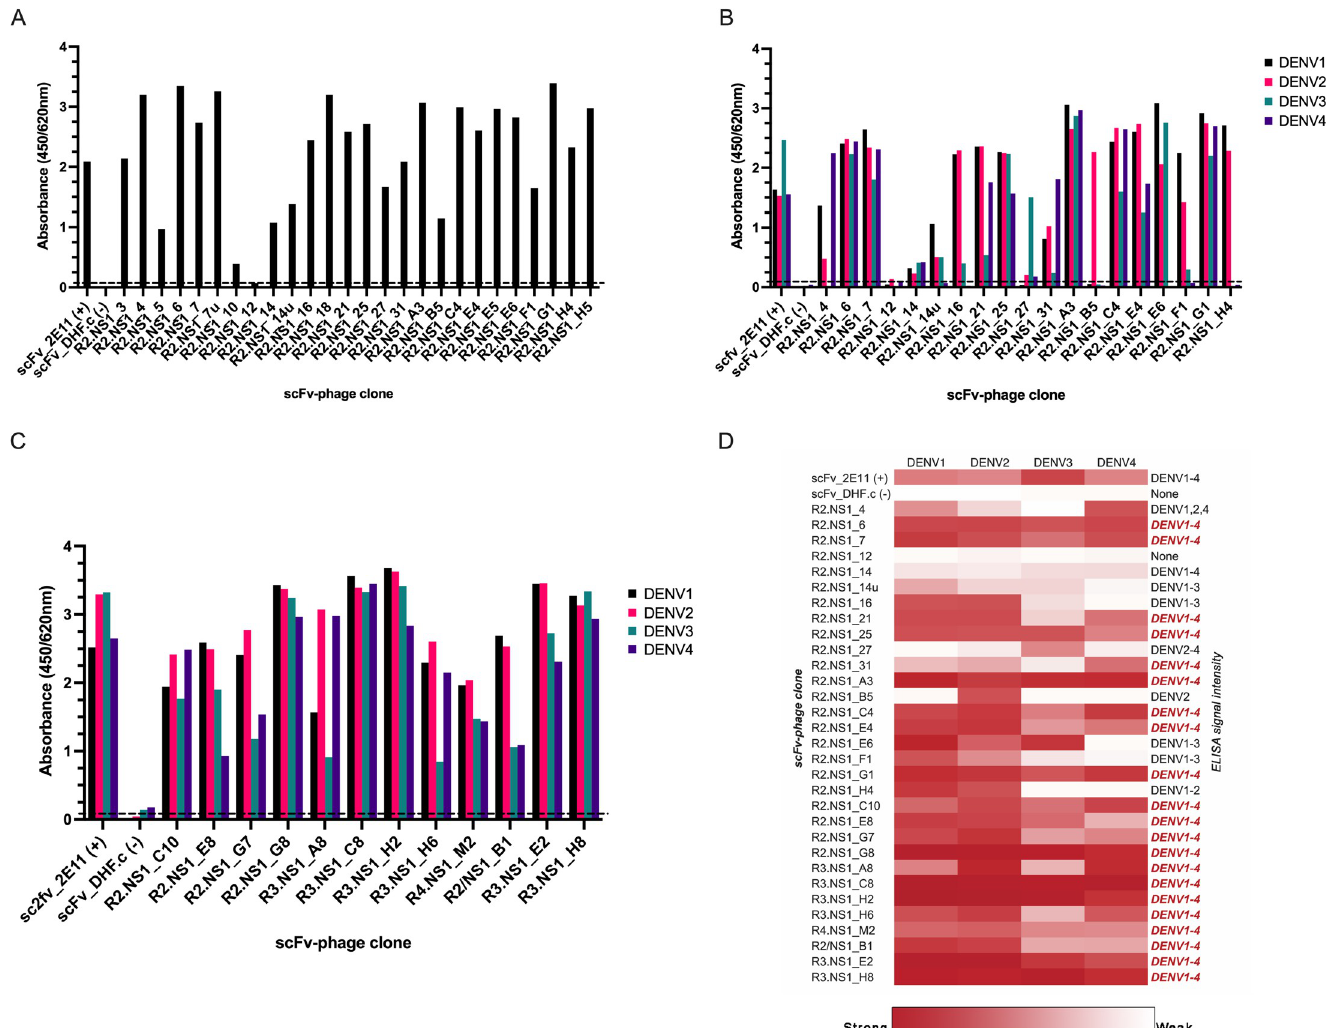
Fig 2. NS1-specific phage clones. (A) The reactivity of the scFv phages biopanned with pooled DENV NS1 was measured by monoclonal phage ELISA using pooled DENV1-4 NS1. (B) & (C) Selected scFv phage clones from the first (pooled DENV1-4 NS1) and second biopanning (separated NS1 from each serotype) experiments were tested with each DENV1-4 NS1 by phage ELISA. The cut-off value shown in (A-C) is OD 450/620 nm. = 0.1. The values are from a single experiment. (D) ELISA signal intensity of the scFv phage’s binding to DENV NS1 obtained from two experiments is shown in a heat map. The spectrum of red to white indicates the range of good to no binding of scFv phages on DENV